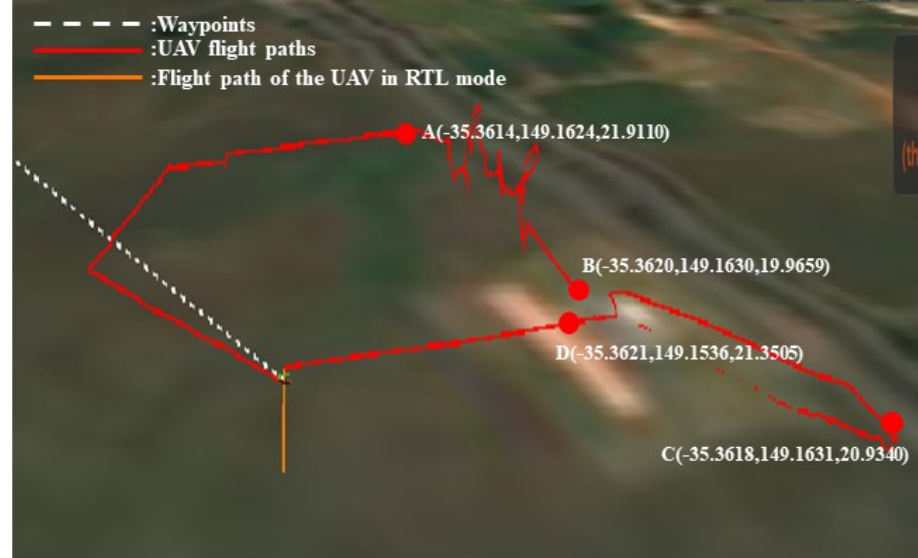
Figure 11. The flight trajectory of the UAV in the state of accelerometer failure. Figure 11. The fl ight trajectory of the UAV in the state of accelerometer failure.